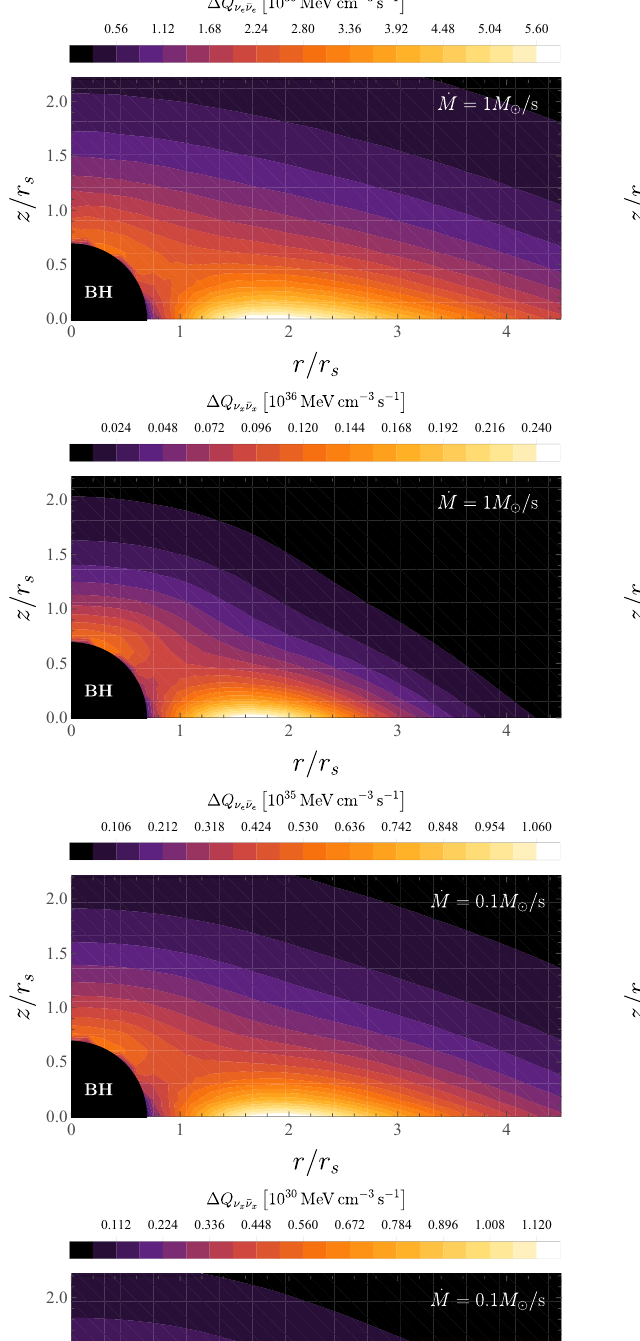
∆ Q = ∑ ν i ¯ ν i kk (cid:48) between disk without k , k (cid:48) i ¯ ν i